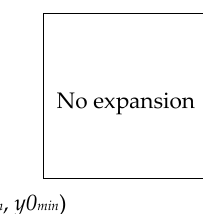
Figure 5. No expansion in the tile map.